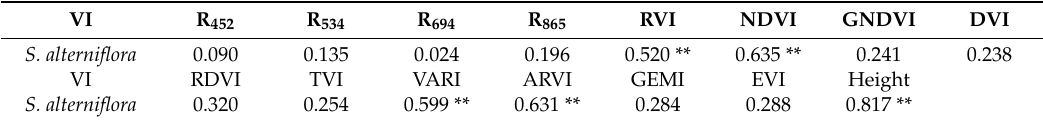
Table 3. Correlation coefficients between S. alterniflora biomass and spectral